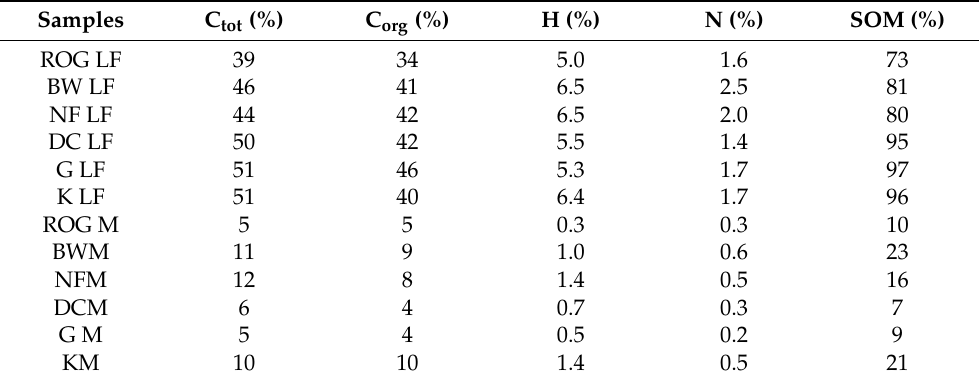
Table 1. Elemental composition of soil samples selected for this review. SOM percentages are determined by thermogravimetry (TG). LF indicates samples from the soil surface representing organic matter at a low degree of decomposition. M represents mineral soil samples taken in the same places as LF but at 5 cm depth from surface, where SOM is more transformed than LF layers. Samples ROG, BW, and NF come from the Alice Holt Research Station in the southeast of the UK. Samples DC, G, and K are from the southwest of Ireland and were used in previous work [26]. All of them represent mature forest oak